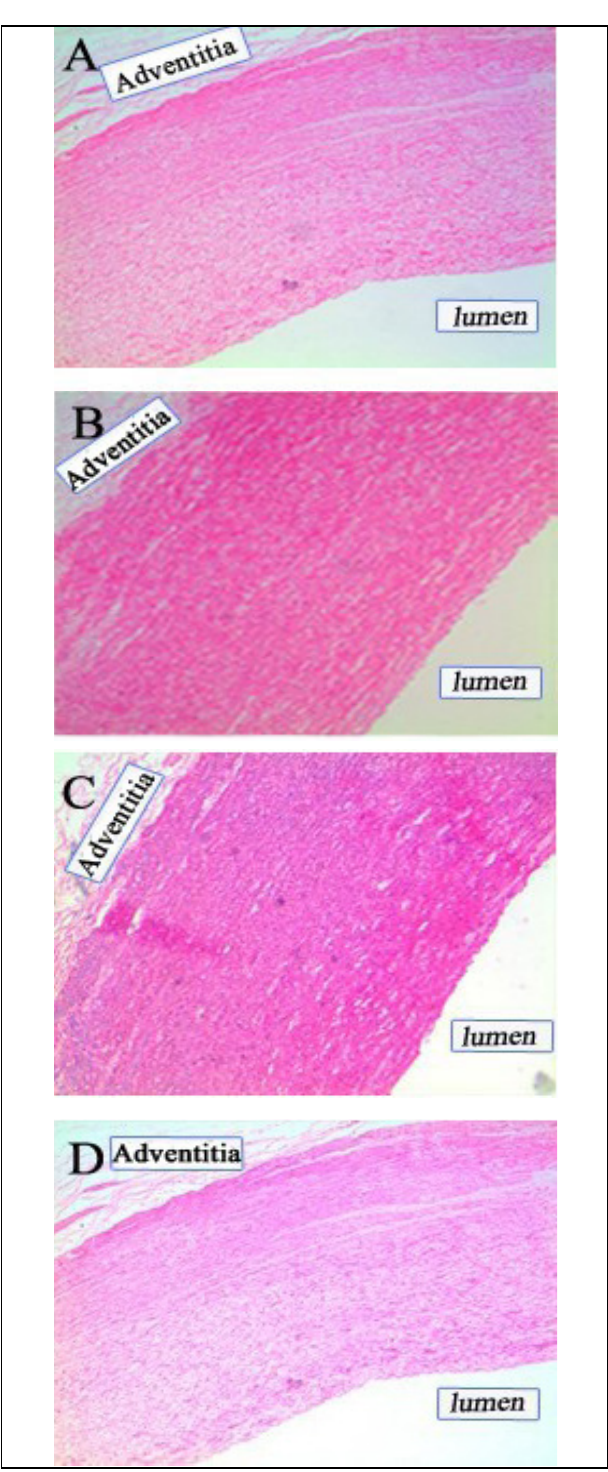
Fig. 8 - Histopathological changes in thoracic aorta implanted with stent-graft. (A) Thoracic aorta of 3 months after implantation. (B) Thoracic aorta of 6 months after implantation. (C) Thoracic aorta of 9 months after implantation. (D) Thoracic aorta of 12 months after implantation. Magnification,